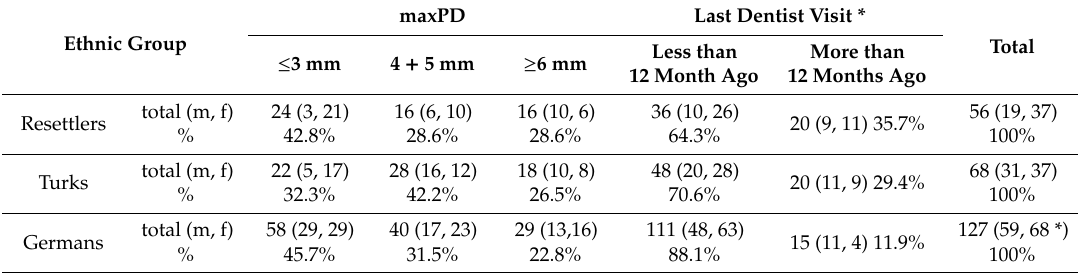
Table 2. Overall distribution of maximal pocket depth (maxPD) and frequency of dentist visits, by ethnic group and